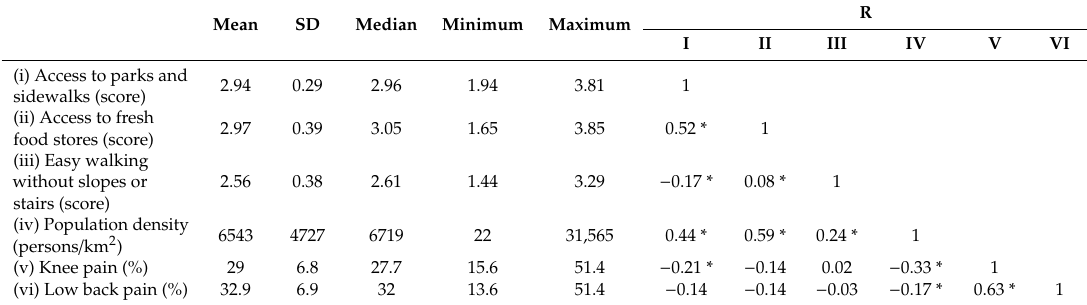
Table 2. Pearson correlations between neighborhood walkability factors and pain.